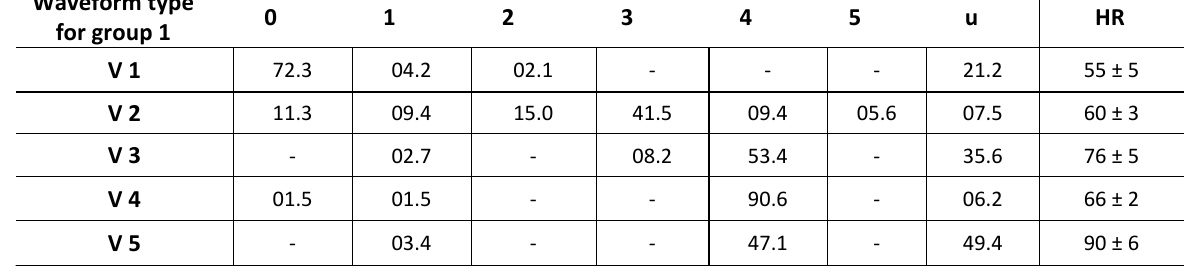
Table 3. Percentage of ABEXYOZ complexes in each recording per volunteer with the average heart-rate (mean ± SD) for group 1 Waveform type for group